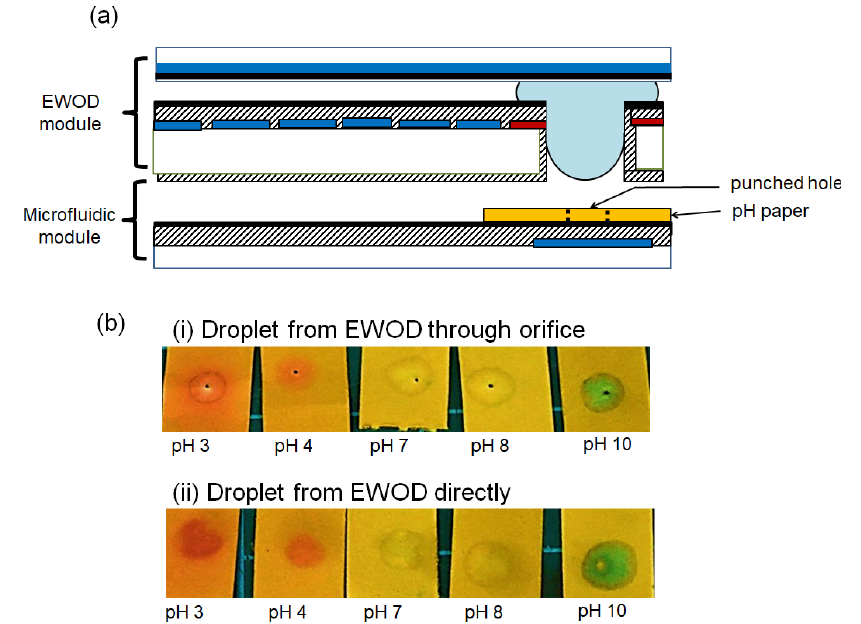
Figure 7. ( a ) Configuration of an EWOD device with pH paper. The pH paper has a punched hole, aligned to the orifice. ( b ) The results of transferring core–shell droplets on an EWOD device to pH paper: ( i ) The core–shell droplets are transferred through the orifice. Only some of the oil shell is transferred onto the pH paper with a minimal oil ring. ( ii ) The core–shell droplets are transferred directly (without the orifice). More of the oil shell is transferred onto the pH paper with an obvious oil stain.